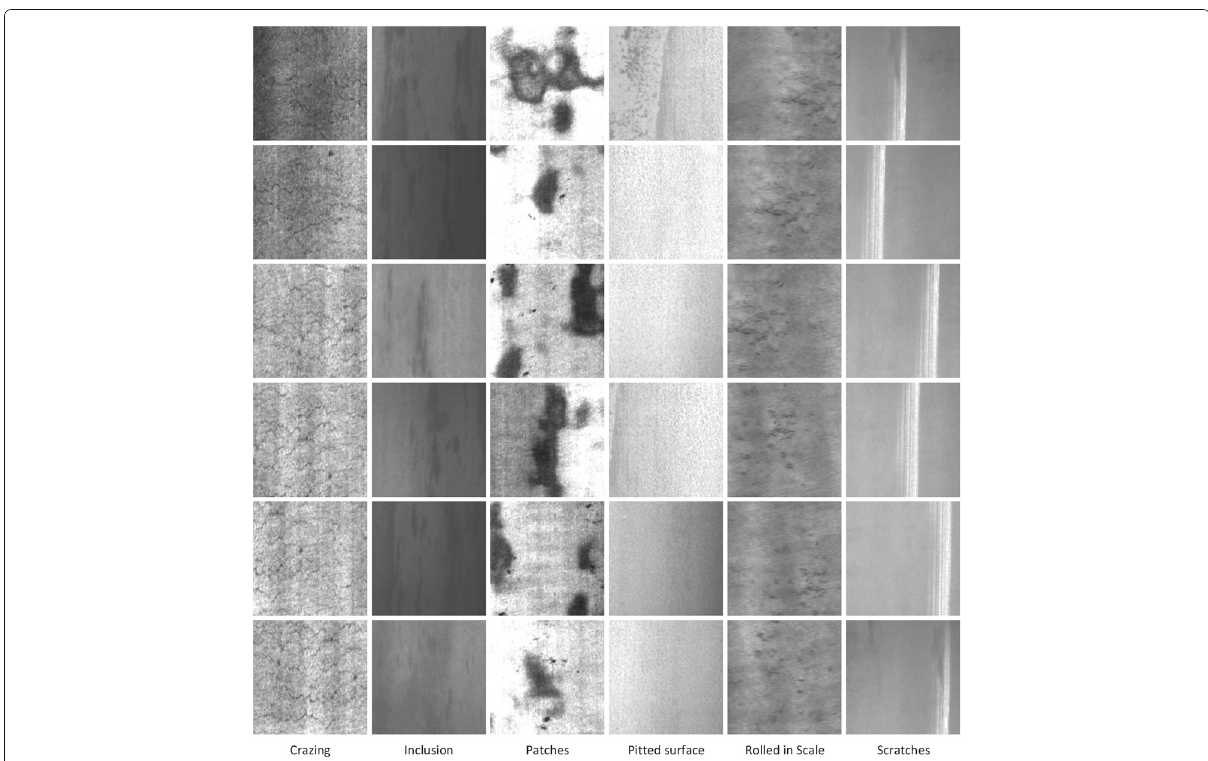
Fig. 6 Defect images, with eachrow being one of the six typical surface defects in the NEU database of sampling from 300 samples for one class Gaussian noise with standard deviation 1, and so on. The decline as the standard deviation increases. The accura- accuracy associated with the SVM is higher than the cor- cies of the KNN, SVM, and BPNN classifiers decline by responding values for the KNN, original BYEC, and BYEC nearly 30%, and the original BYEC classifier declines a lit- classifiers for the original data set, but the accuracies of tle more slowly than them. One possible reason for the the SVM, KNN, BPNN, and original BYEC classifiers all slower decrease of the original BYEC classifier may be